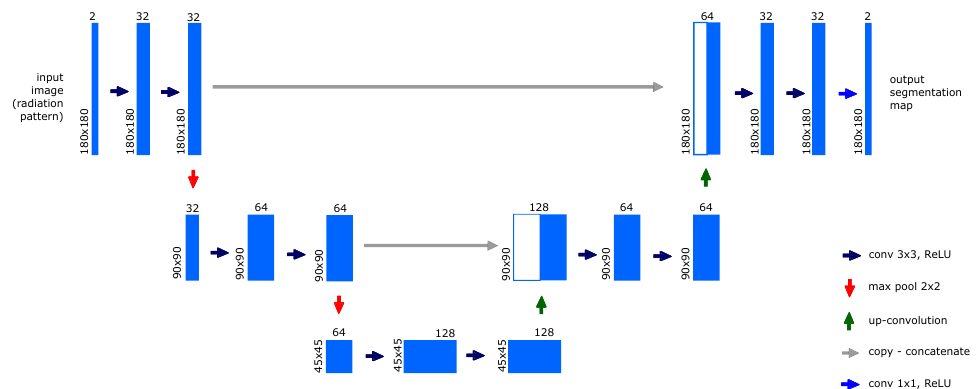
Figure 4. U-Net: fully convolutional